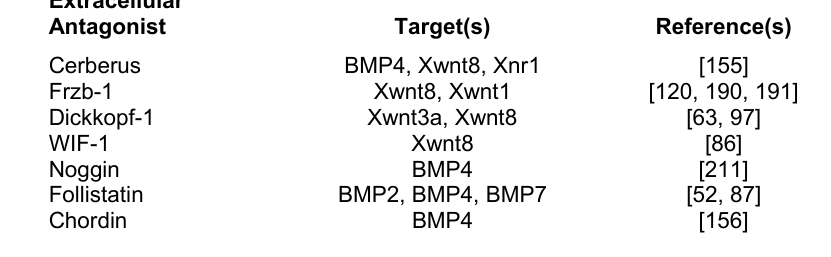
Antagonistic Partners in Embryonic